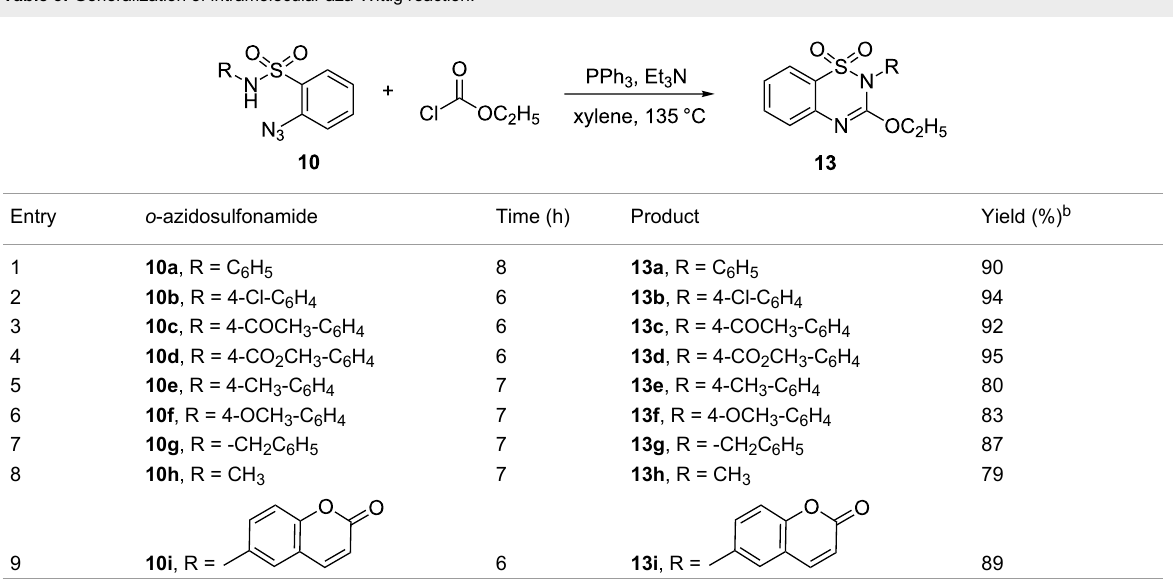
Table 3: Generalization of intramolecular aza-Wittig reaction. a